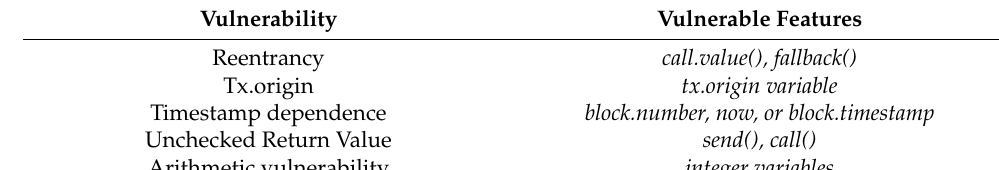
Table 1. The vulnerable features corresponding to different vulnerabilities.